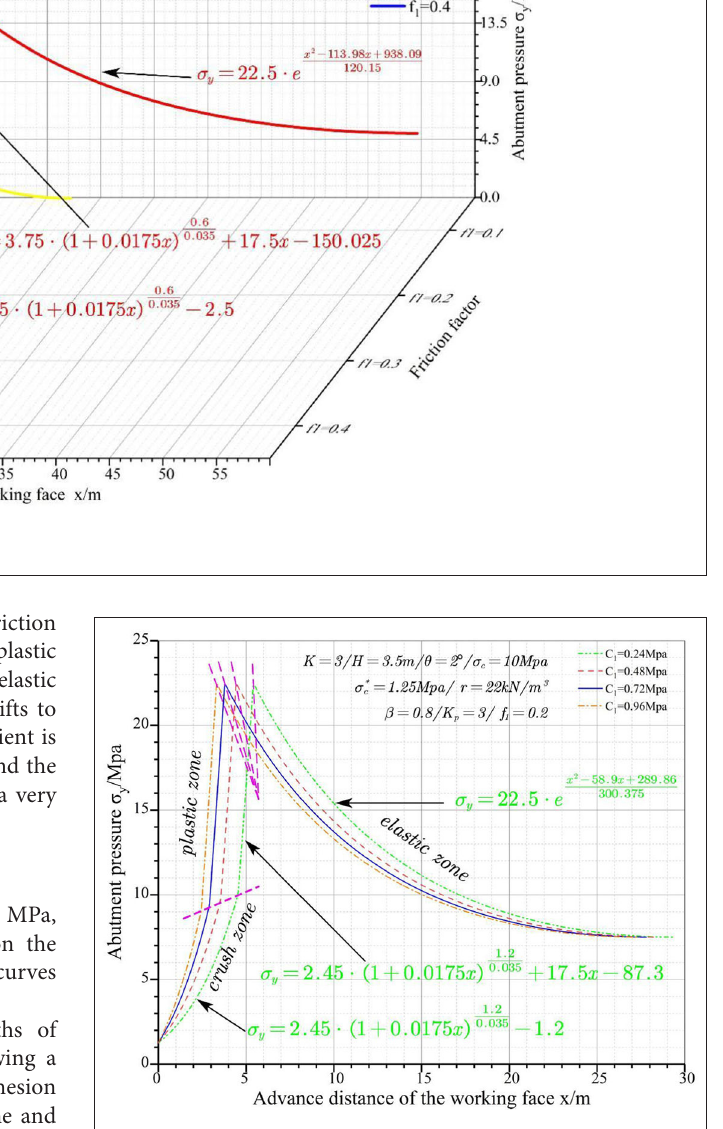
FIGURE 8 | Impacts of cohesion on abutment